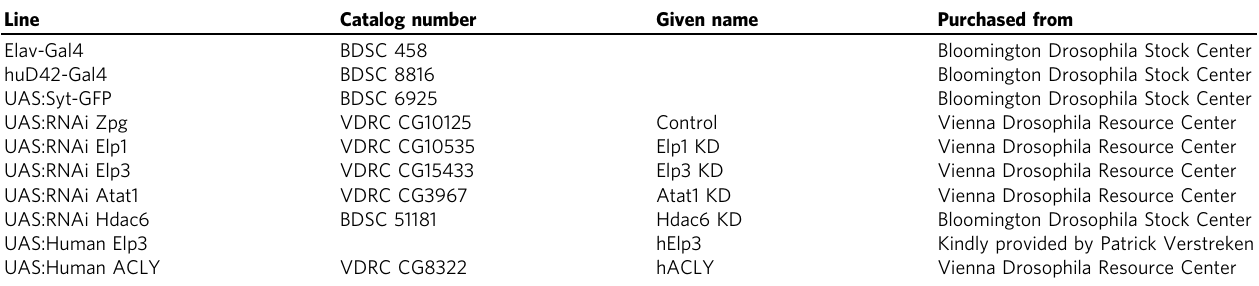
Table 1 Drosophila melanogaster